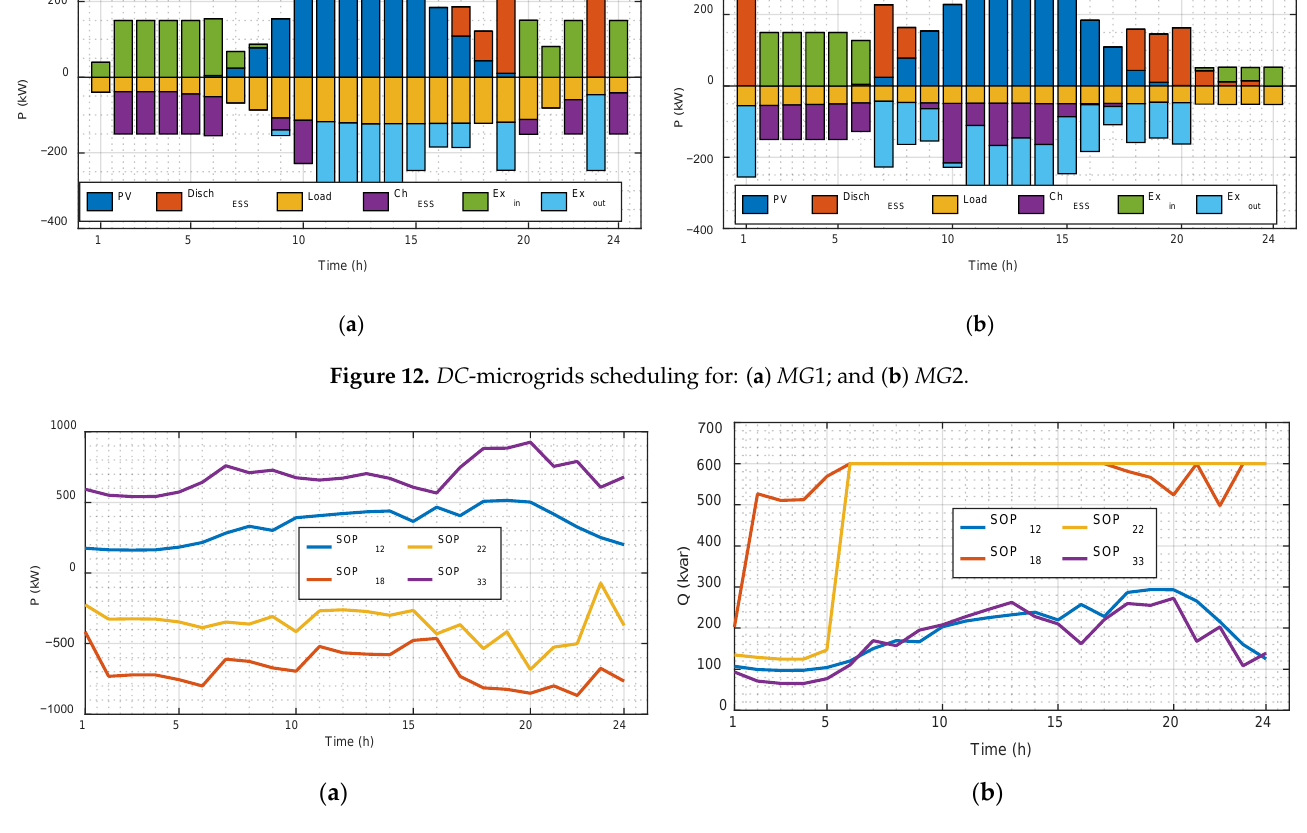
Figure 13. SOPs’ converters output: ( a ) active power; and ( b ) reactive power. To further analyze the influence of the SOP on the supply recovery, the restoration rates for the three classes of loads are shown in Figure 14. A substantial improvement can be observed for this restoration scheme, as the first priority loads were completely sup- plied for the entire day. The SOP’s generation of reactive power reduced the line loadings, expanding the active power flow capacity in the ADN. As a result, the obtained restora- tion ratios for priorities I, II and III loads were as follows: 100%, 87.55% and 60.94%, re- spectively.